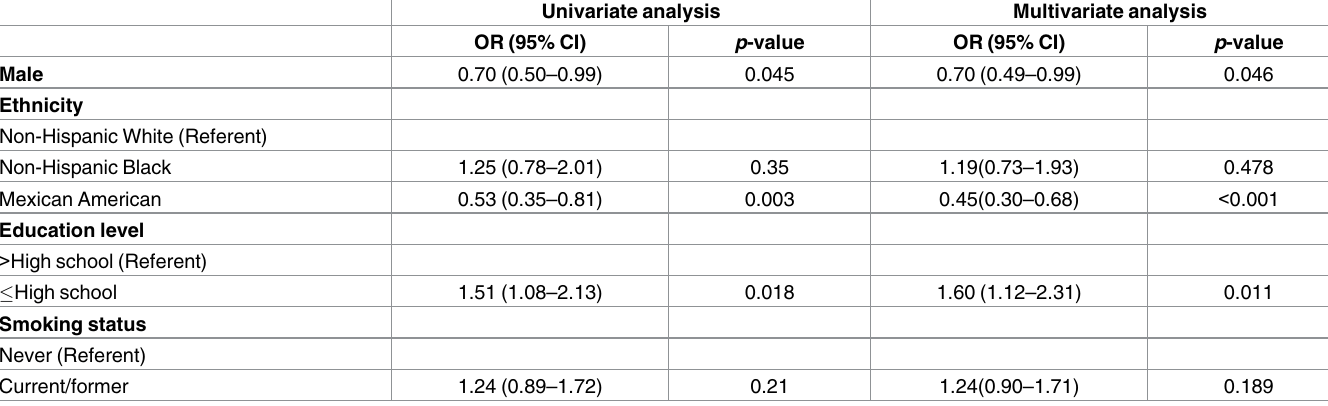
Table 3. Predictors for advanced fibrosis in participants with NAFLD in the U.S. National Health and Nutrition Examination Survey, 1999–2012 (n =